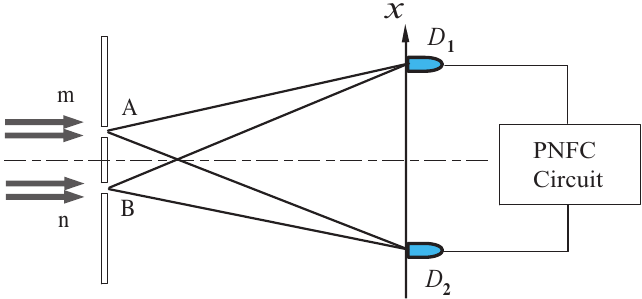
Figure 3. Two-photon Young’s double-slit interference experiment. The interferometer is a standard Young’s double-slit interferometer, except the measurement is (cid:104) ∆ I ( x 1 ) ∆ I ( x 2 ) (cid:105) by means of the use of two point-like scannable photodetectors D 1 and D 2 , as well as the PNFC (Photon Number Fluctuation Correlation) measurement circuit. The separation between the upper slit-A and the lower slit-B is much greater than the coherence length of the thermal field, d (cid:29) l c . Consequently, no first-order interferences are observable from (cid:104) I ( x 1 ) (cid:105) and (cid:104) I ( x 2 ) (cid:105) . The question is: do we observe interference from (cid:104) ∆ I ( x 1 ) ∆ I ( x 2 ) (cid:105)